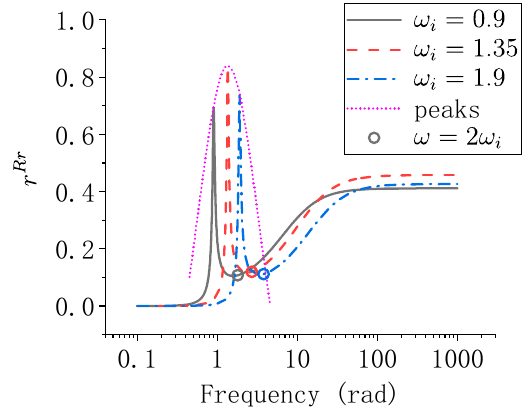
Table 3. Error ratio (cid:1870) (cid:3036)(cid:3019)(cid:3045) for different (cid:2021) , (cid:2014) and (cid:1871) (cid:3036) (cid:2247)